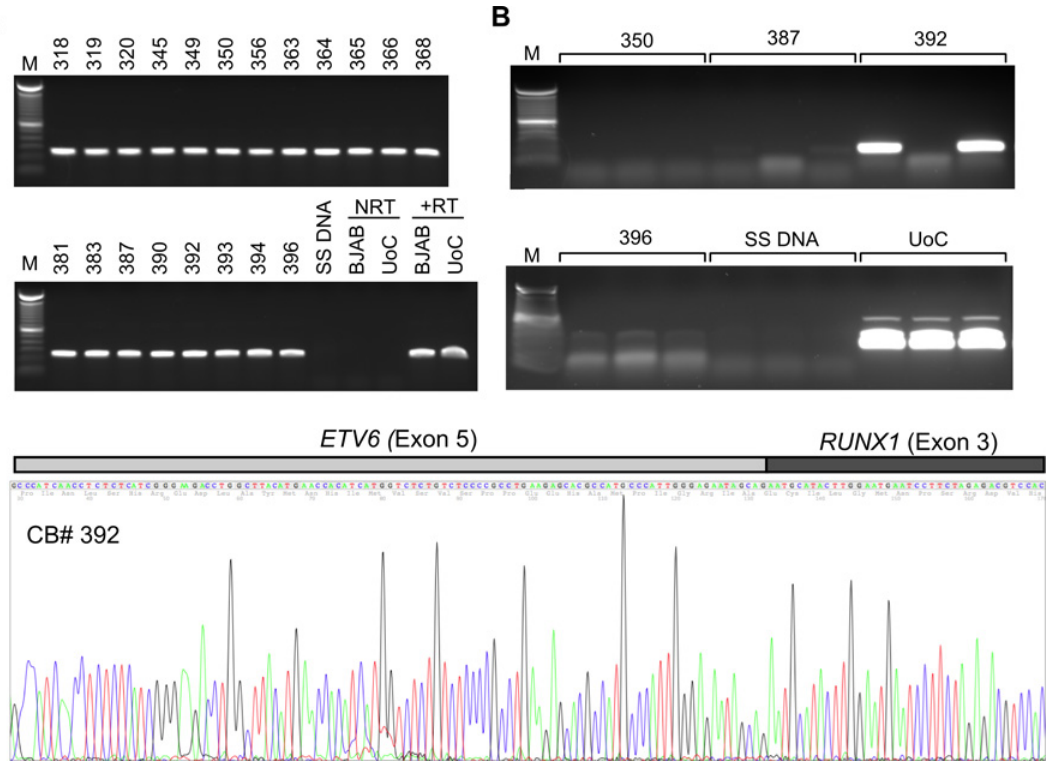
Fig 3. Detection of the ETV6-RUNX1 fusion transcript by reverse transcription followed by PCR. 200 ng of RNA purified from umbilical vein cord blood lymphocytes was reverse transcribed using random hexamers as primers. (A) The integrity of the RNA in the numbered cord blood samples was confirmed by amplification of a 384 bp sequence spanning the junction of exons 3 and 4 of the β -2-microglobulin gene. Positive controls included RNA from the BJAB and UoCB4 cell lines (+RT). Negative controls included salmon sperm DNA (SS DNA) and the exclusion of reverse transcriptase (NRT). Lanes containing the 100 bp DNA ladder reference are indicated by M. (B) A 200 bp amplicon obtained from a nested PCR assay indicates the presence of the ETV6-RUNX1 transcript. Representative results show the products of three technical replicates from four numbered cord blood samples, salmon sperm DNA as a negative control, and a 10 -2 dilution of the ETV6-RUNX1 -positive UoCB4 cells among BJAB cells as a positive control. Samples in which at least two of three technical replicates were detected from cDNA generated independently in two laboratories and in which no product was observed when reverse transcriptase was omitted were considered to contain the ETV6-RUNX1 fusion transcript. (C) The ETV6-RUNX1 amplicon generated from cord blood sample 392 was subjected to sequencing with the primers used to generate the product. The sequencing electropherogram from one of two reactions demonstrates the structure of the expected fusion